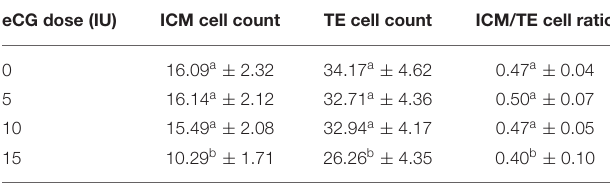
The data are expressed as the means ± SDs. a , b Within a column, values with different superscripts are significantly different (P <